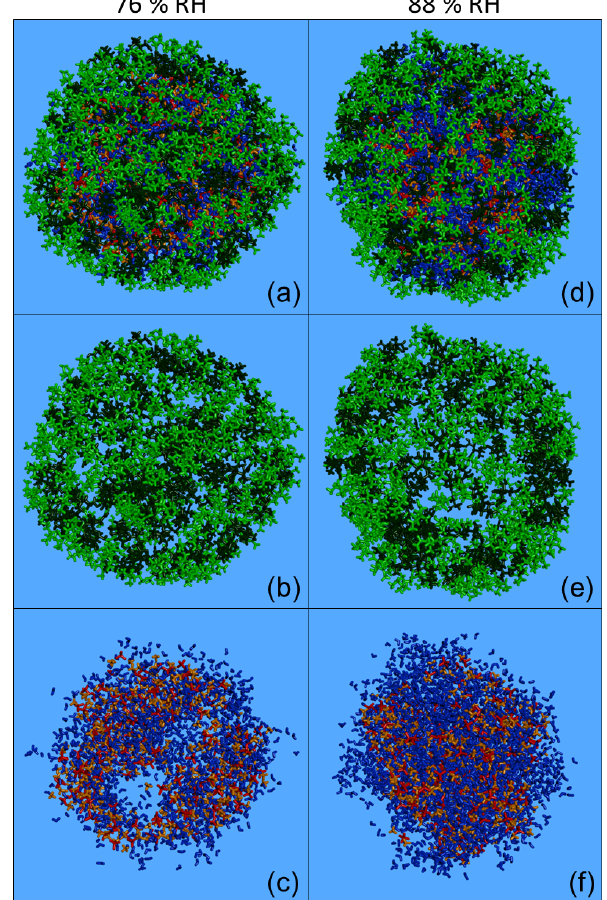
Figure 10. Characteristic snapshots from the MD simulations of the nanoparticles containing (dry-mass fraction) 36% CPA and 39% MBTCA (a) at 76% RH, (b) at 76% RH including only organic molecules, (c) at 76% RH omitting organic molecules, (d) at 88% RH, (e) at 88 % RH including only organic molecules and (f) at 88% RH omitting organic molecules. Colour coding: green for CPA, dark green for MBTCA, red for sulfate, orange for ammo- nium and blue for